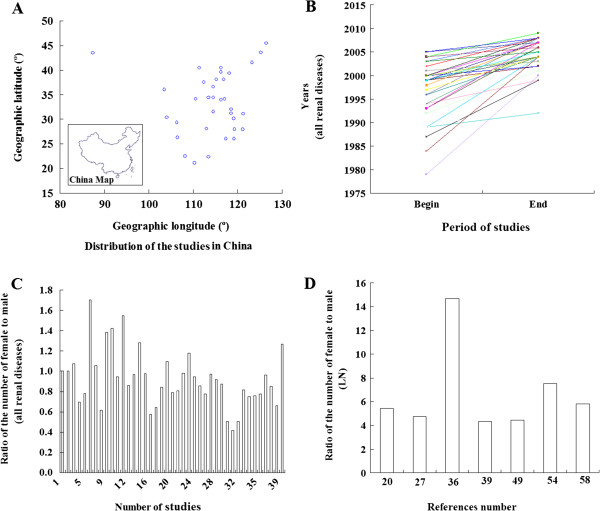
The characteristics of the study centers included in the analyses. The distribution of the studies in China (A), the study period, from the beginning to the end, for all renal diseases (B), the ratio of the number of females to males in all cases of renal disease (C) and the ratio of the number of females to males in LN disease (D).